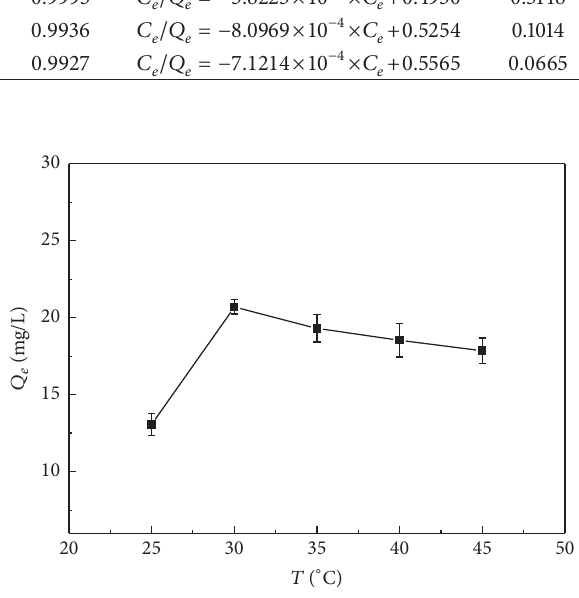
Figure 10: Effect of adsorption temperature on adsorption capacity of CA4 in 10mg/L methyl orange